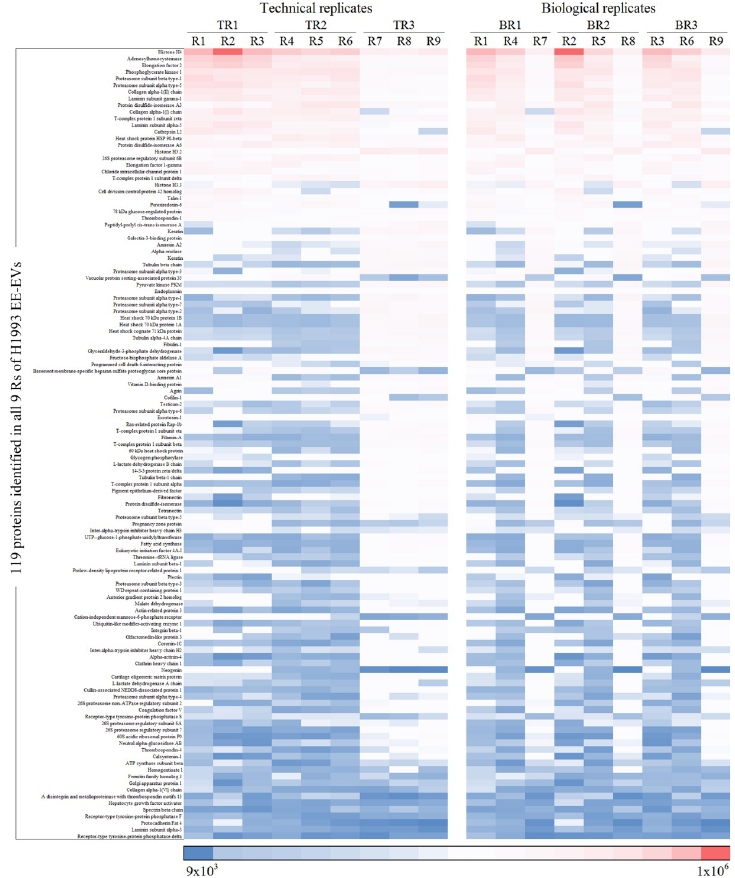
Fig 7. Heatmap representing exosomal proteins identified in H1993 in order of decreasing levels in TRs (R1-R2-R3, R4-R5-R6, R7-R8-R9) and in BRs (R1-R4-R7, R2-R5-R6, R3-R6-R9). Boxes highlighted in dark red represent the most abundant, while boxes in dark blue represent the least abundant